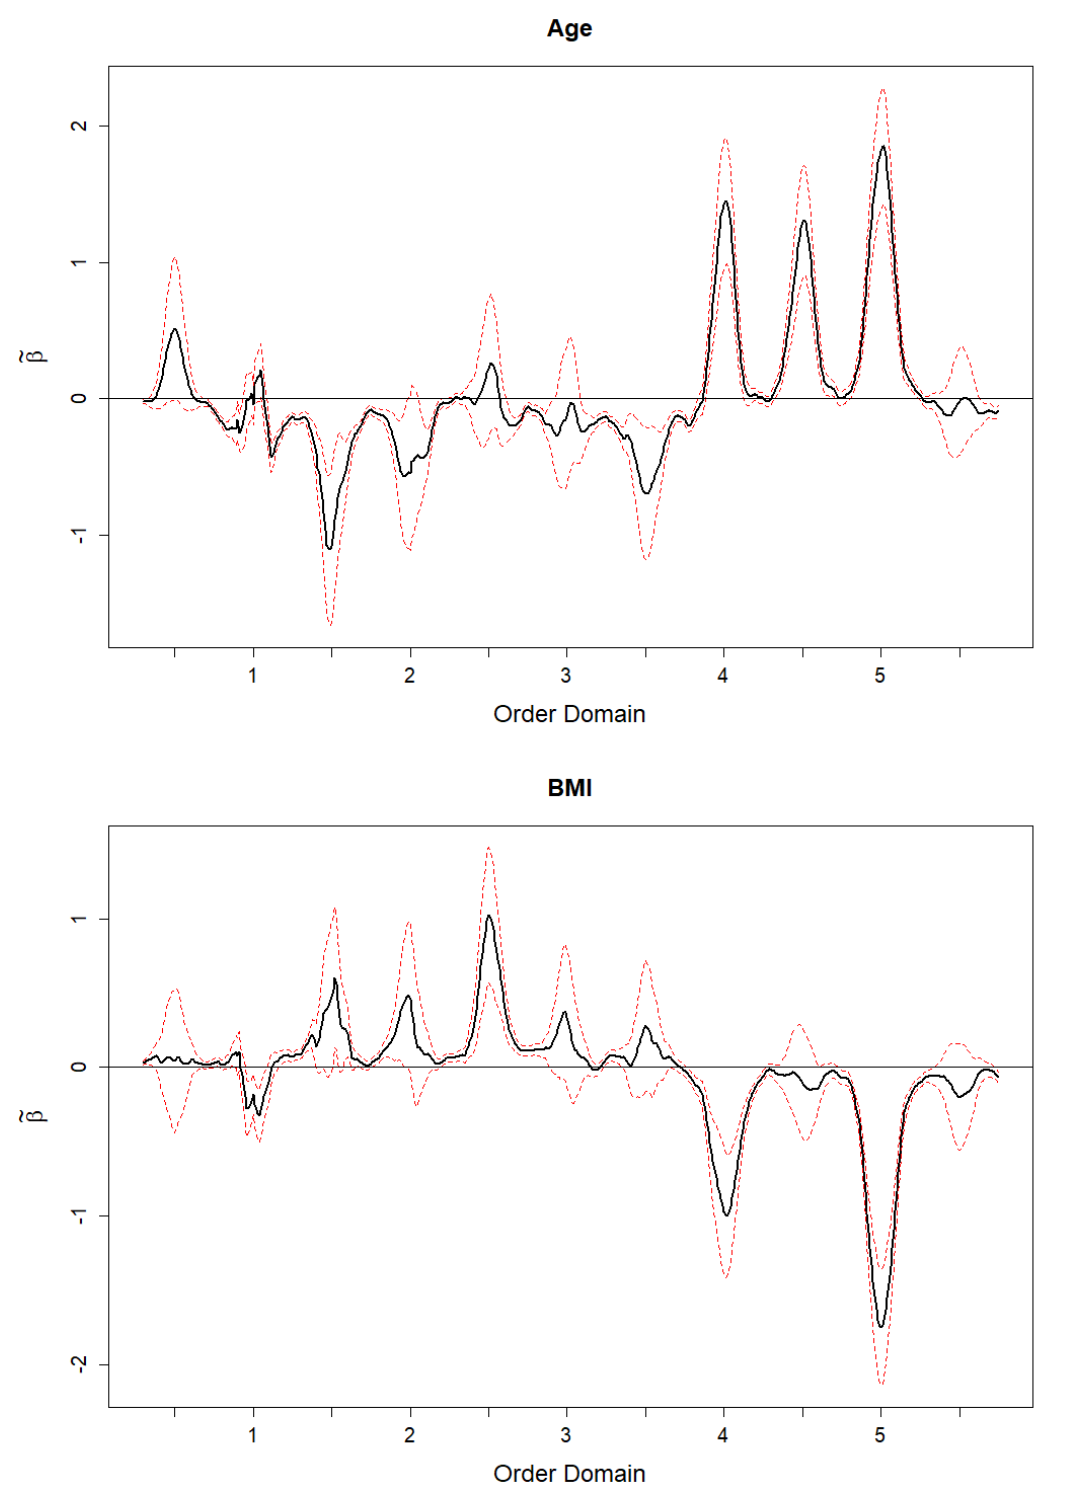
Figure 4. Estimates of the coefficient function, ˜ β , (with 95% point-wise confidence band) for the association of walking with age and BMI, as described in Section 4. The x-axis represents multiples of the frequency of the